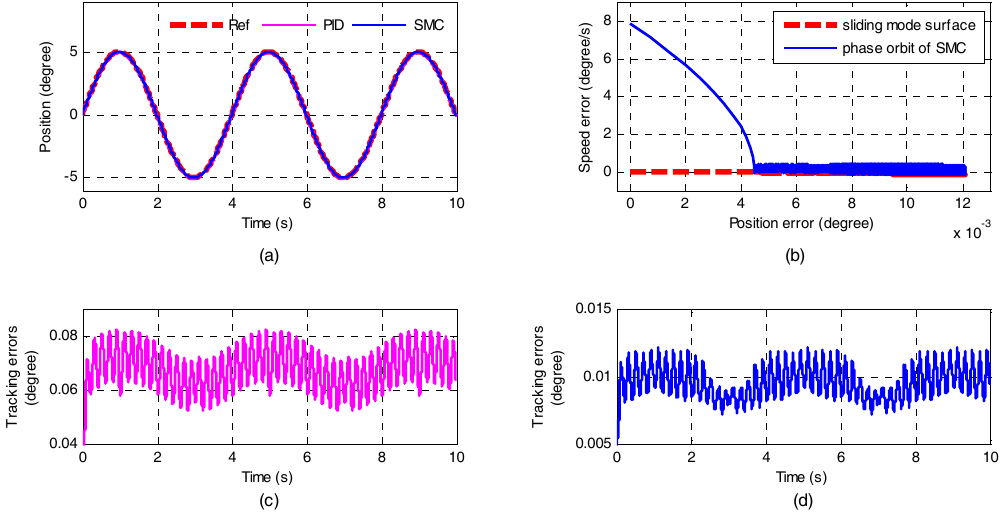
Figure 7. Simulation of sinusoidal response of Joint 2: ( a ) Position tracking; ( b ) Phases trajectory diagram of SMC; ( c ) Tracking error of PID; and ( d ) Tracking error of SMC.